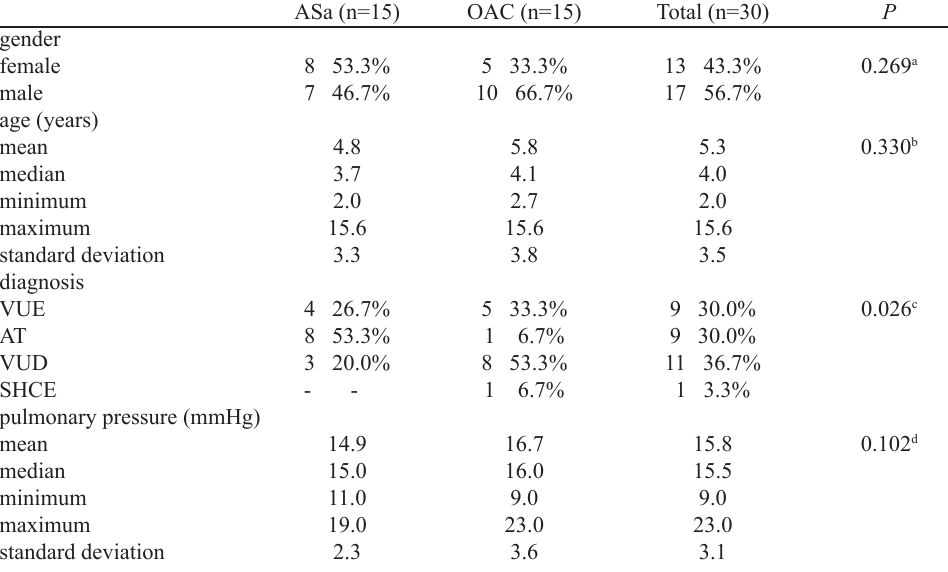
Table 1. Distribution of the general characteristics of children of ASA and OAC groups.